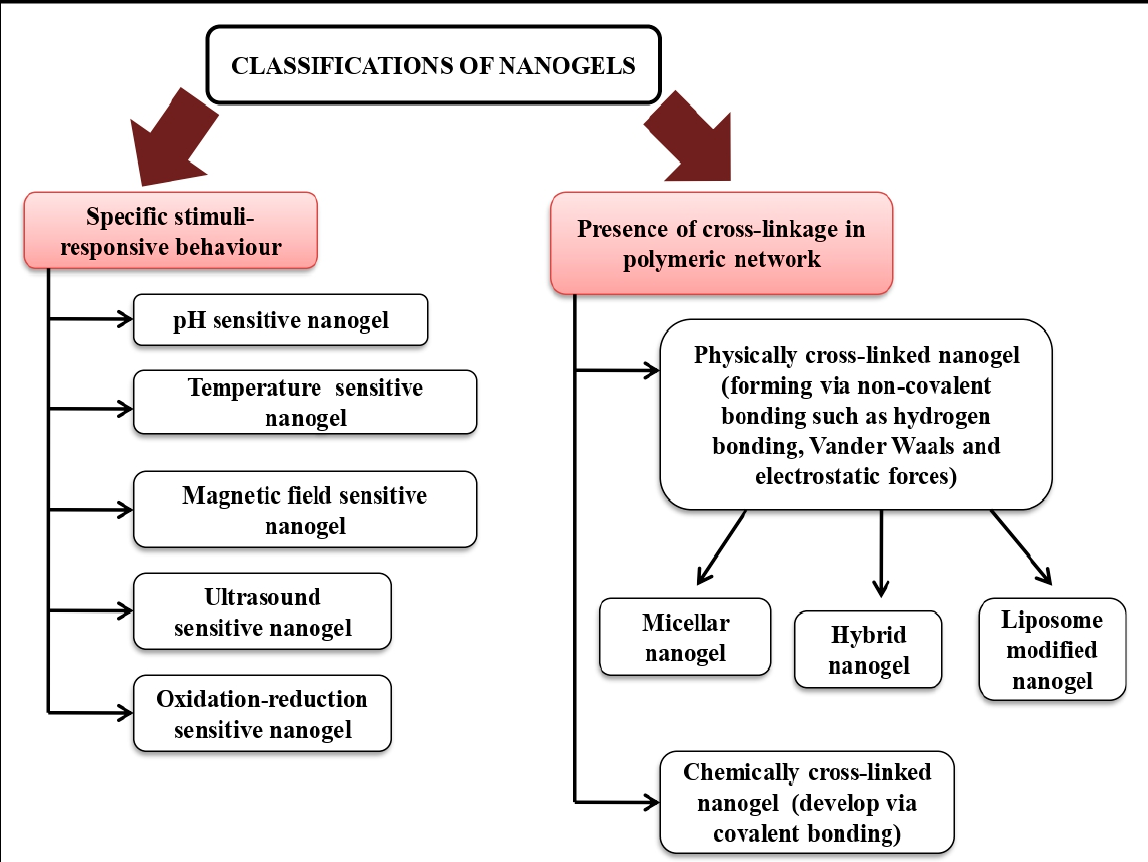
Figure 1. Classifications of nano-gels. Adapted from [25] under creative commons attribution Figure 1. Classi fi cations of nano-gels. Adapted from [25] under creative commons a tt ribution 4.0 4.0 international international license.